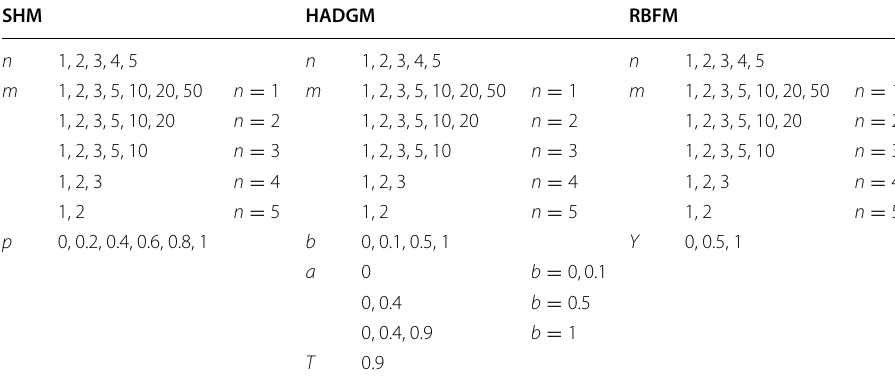
Table 1 Parameter settings for the Song‑Havlin‑Makse, Hub attraction dynamical growth, and Repulsion‑based fractal models, with which the analyzed networks were generated. The parameter n denotes the number of iterations, for the meaning of the other parameters, see the Network models section. The resulting number of networks: 138 (SHM), 161 (HADGM), 69 (RBFM) SHM HADGM RBFM